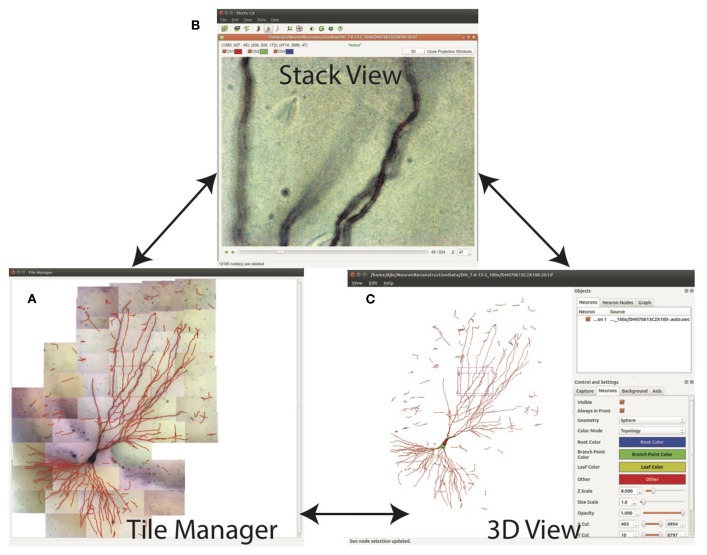
Three views for examining the SWC structure. (A) Tile manager. 2D projection of the stitched stacks is superimposed with the 2D projection of the SWC structure. (B) Stack view. One stack is loaded, with the SWC points in the stack overlaid onto the image. The 2D projection view of the stack can be created within this window. (C) SWC view. The 3D structure can be viewed from different angles and edited.